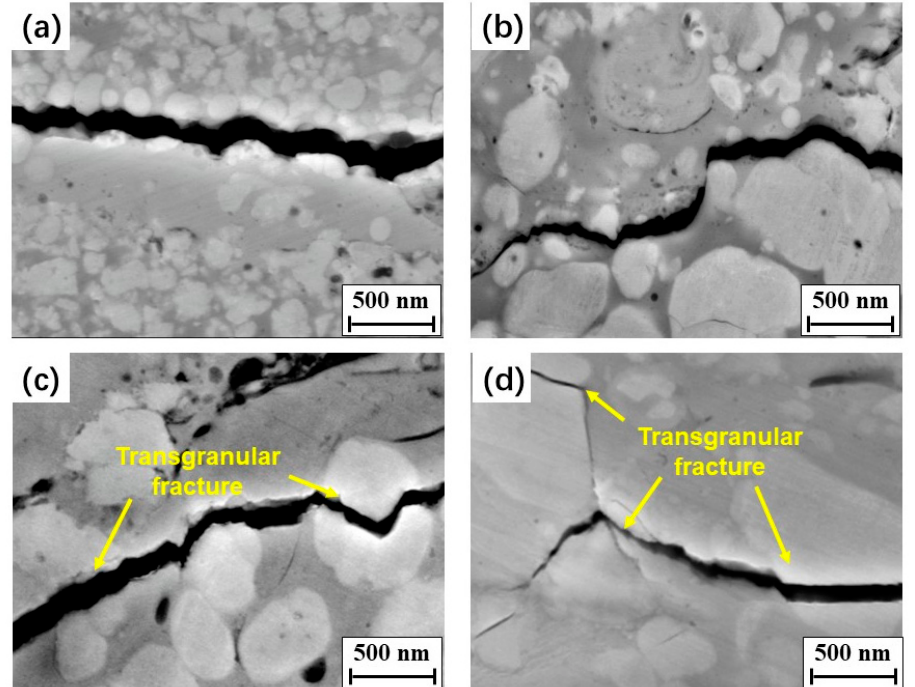
Figure 11. Typical indentation crack profiles in the studied WC–10Co–4Cr coatings: ( a ) N; ( b ) B1; ( c ) M; ( d ) B2.